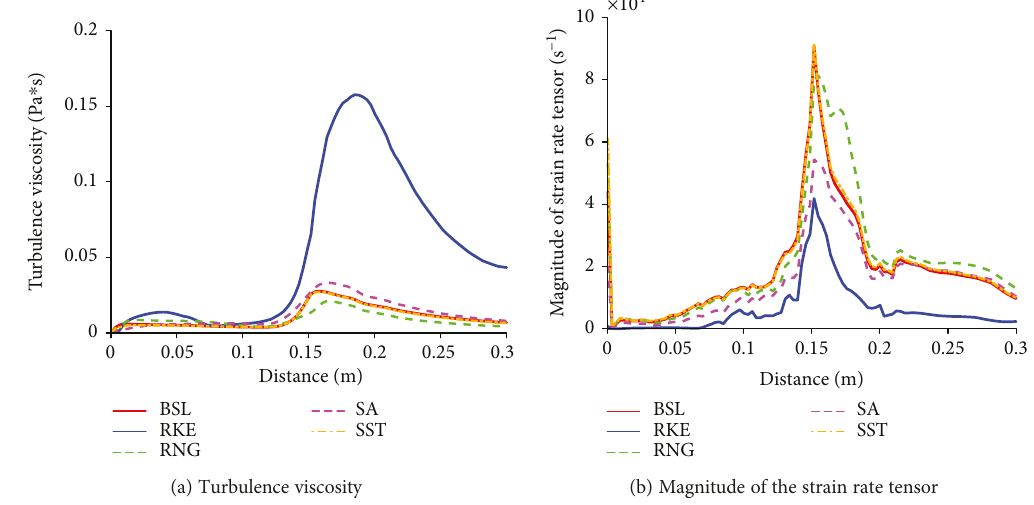
Figure 7: Turbulence viscosity and magnitude of the strain rate tensor along the central axis of the rocket.